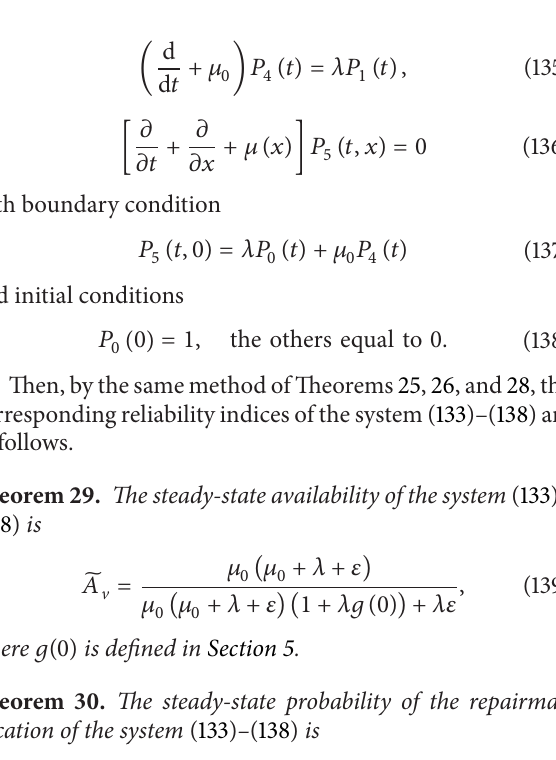
Figure 6: Instantaneous failure frequencies of the systems with and without warning device with 𝛼 = 0.01